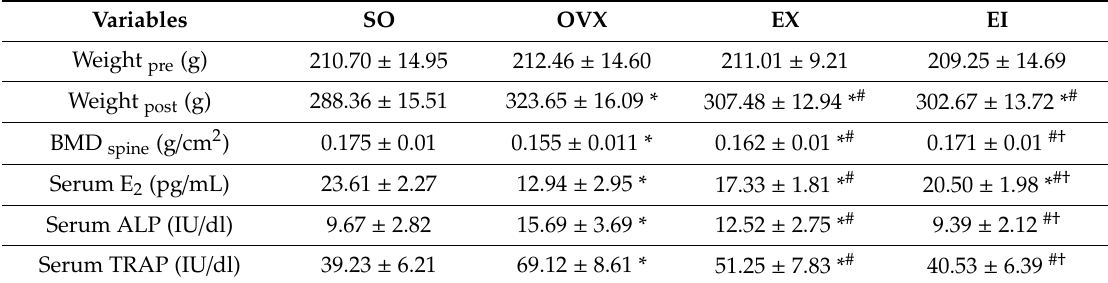
Table 1. Physical and serum parameters of rats between di ff erent treatment